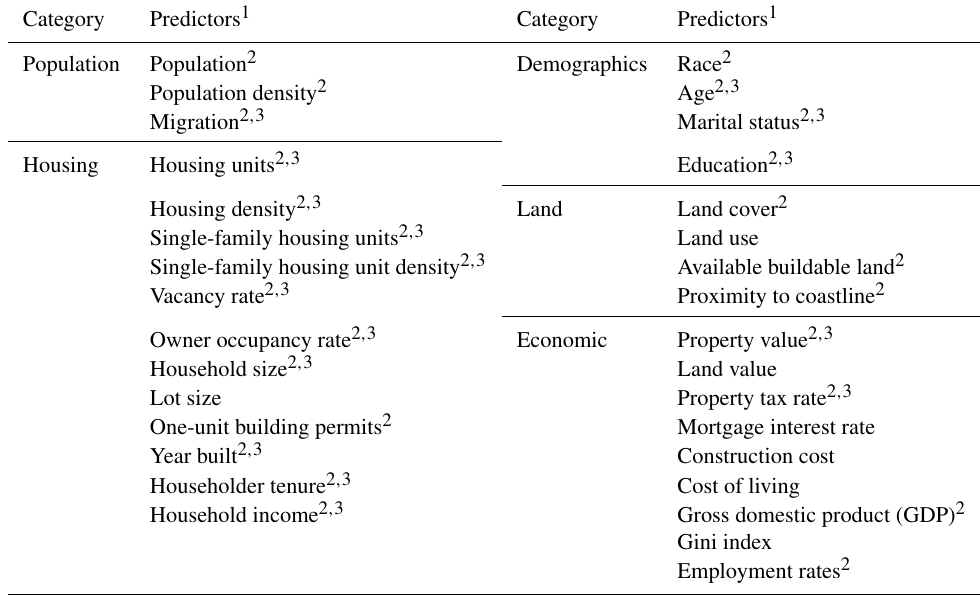
Table 1. Predictors of housing inventory changes over